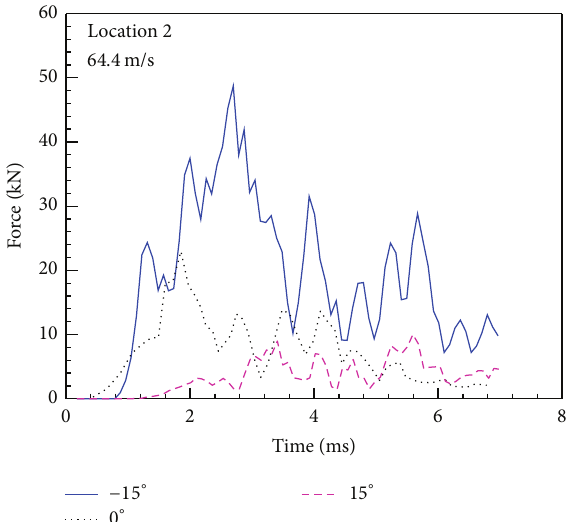
Figure 17: Displacement time plot for different impact angles. Figure 18: Impact force history for different impact